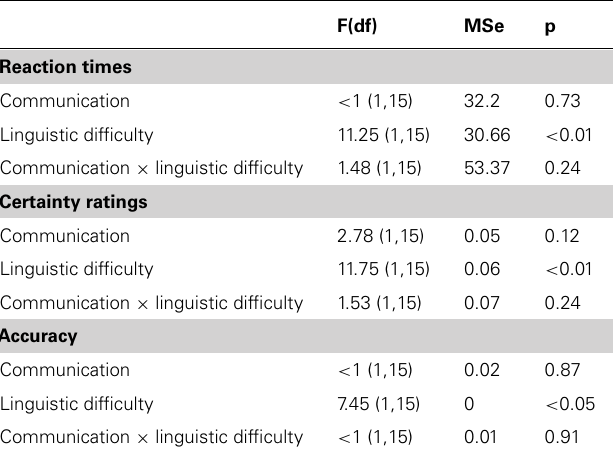
Table 1 | Repeated measures analysis of variance was applied on reaction times, certainty ratings and accuracy scores of Evaluators when listening toTarget-word descriptions made by Communicators in an earlier conducted fMRI experiment.